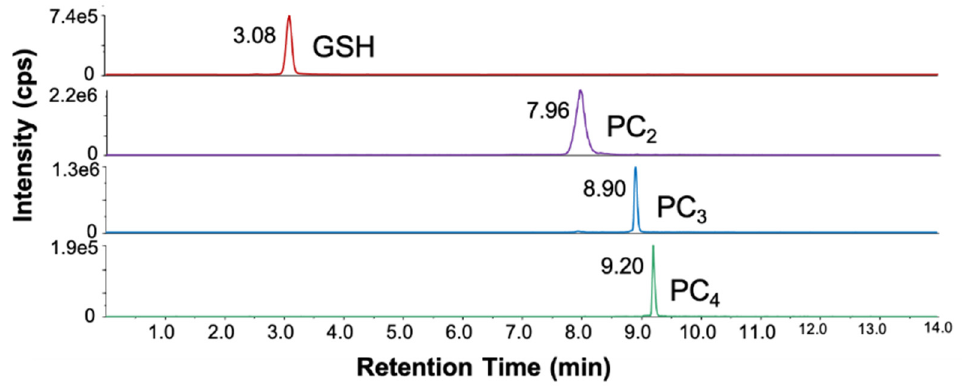
Figure 4. Representative mass spectrometry chromatograms of a partially purified extract from M. polymorpha in the time range of 0–14 min.